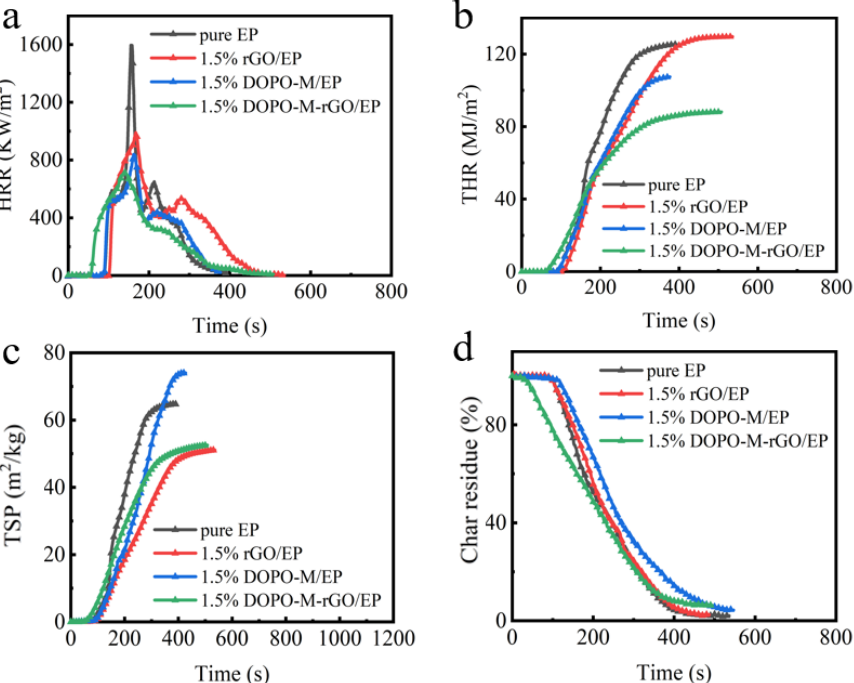
Figure 6. ( a ) Heat release rate; ( b ) total heat release; ( c ) total smoke production; ( d ) char residue curves of the pure EP, rGO/EP composite, DOPO-M/EP composite, and DOPO-M-rGO/EP composite (the mass fractions of additive in the composites are all 1.5%) under an external heat flux of 35 kW/m 2